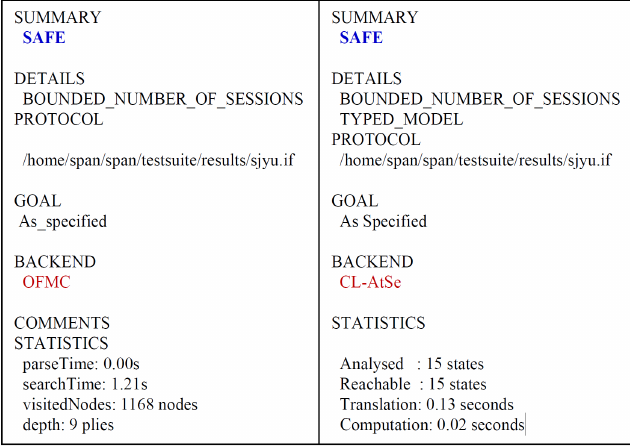
Figure 3. AVISPA results based on CL-AtSe and